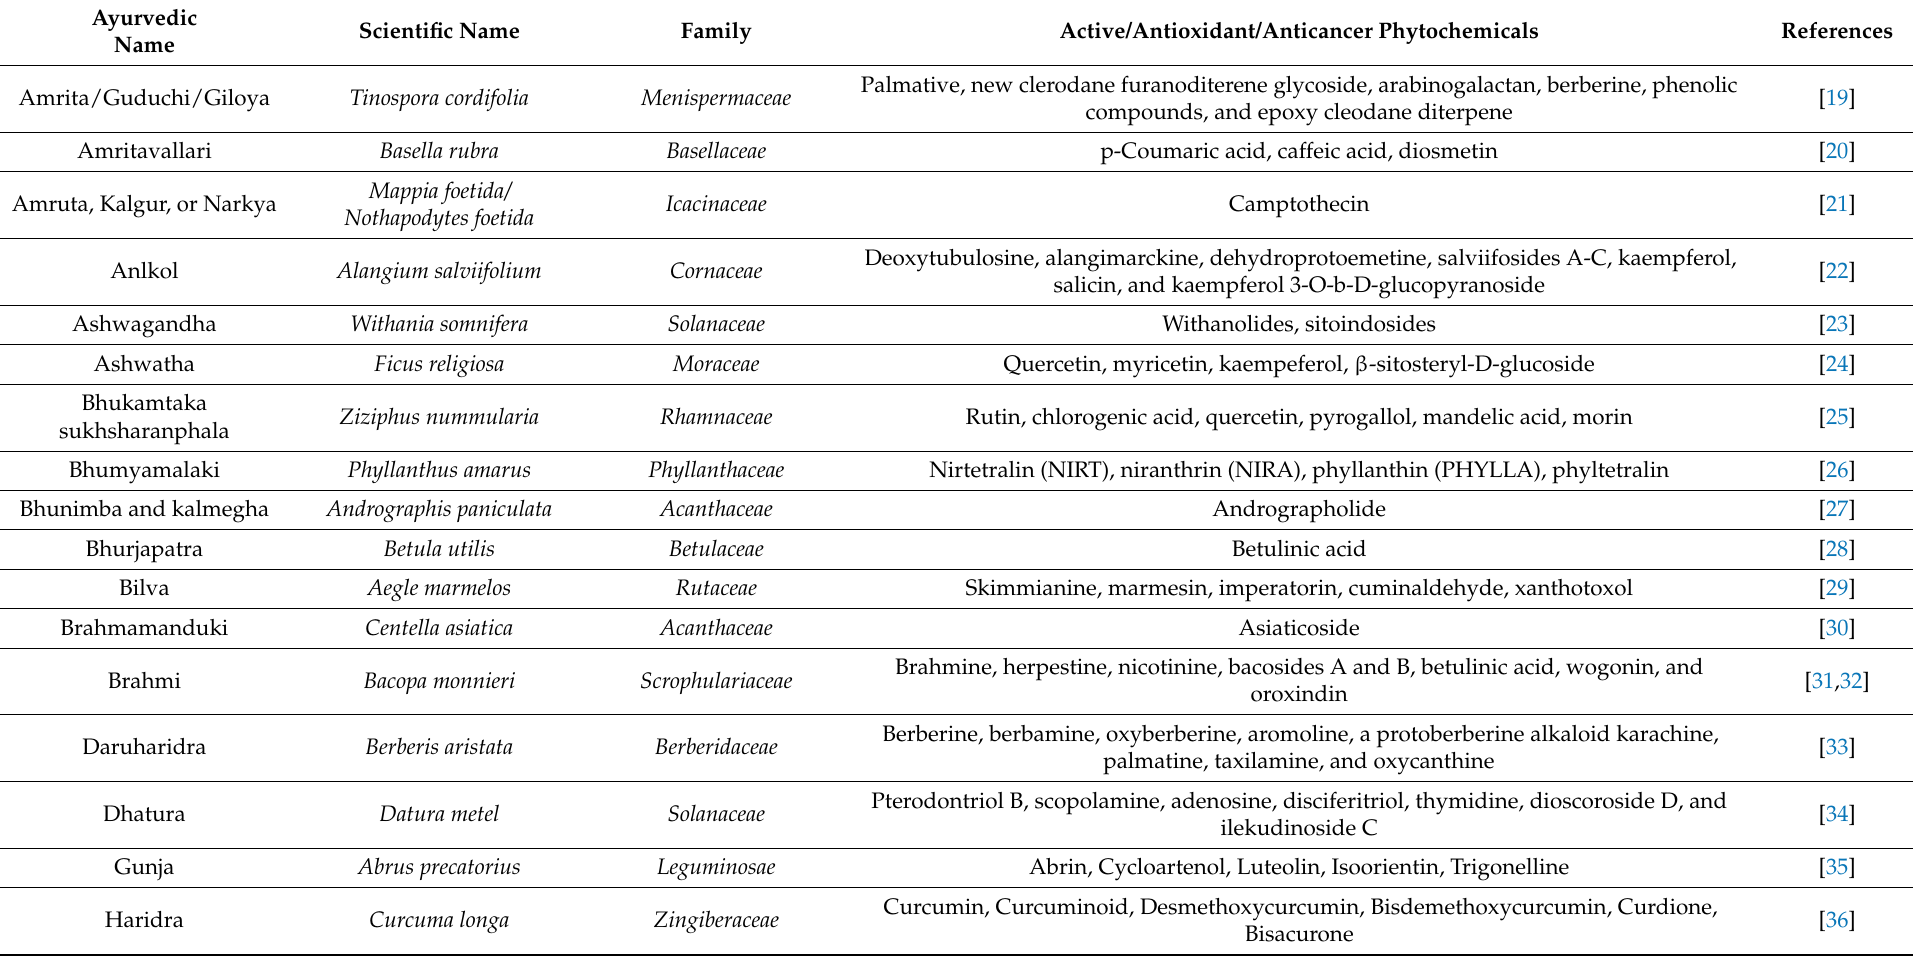
Table 1. A brief list of some ayurvedic medicinal plants having potent anticancer activity and their main